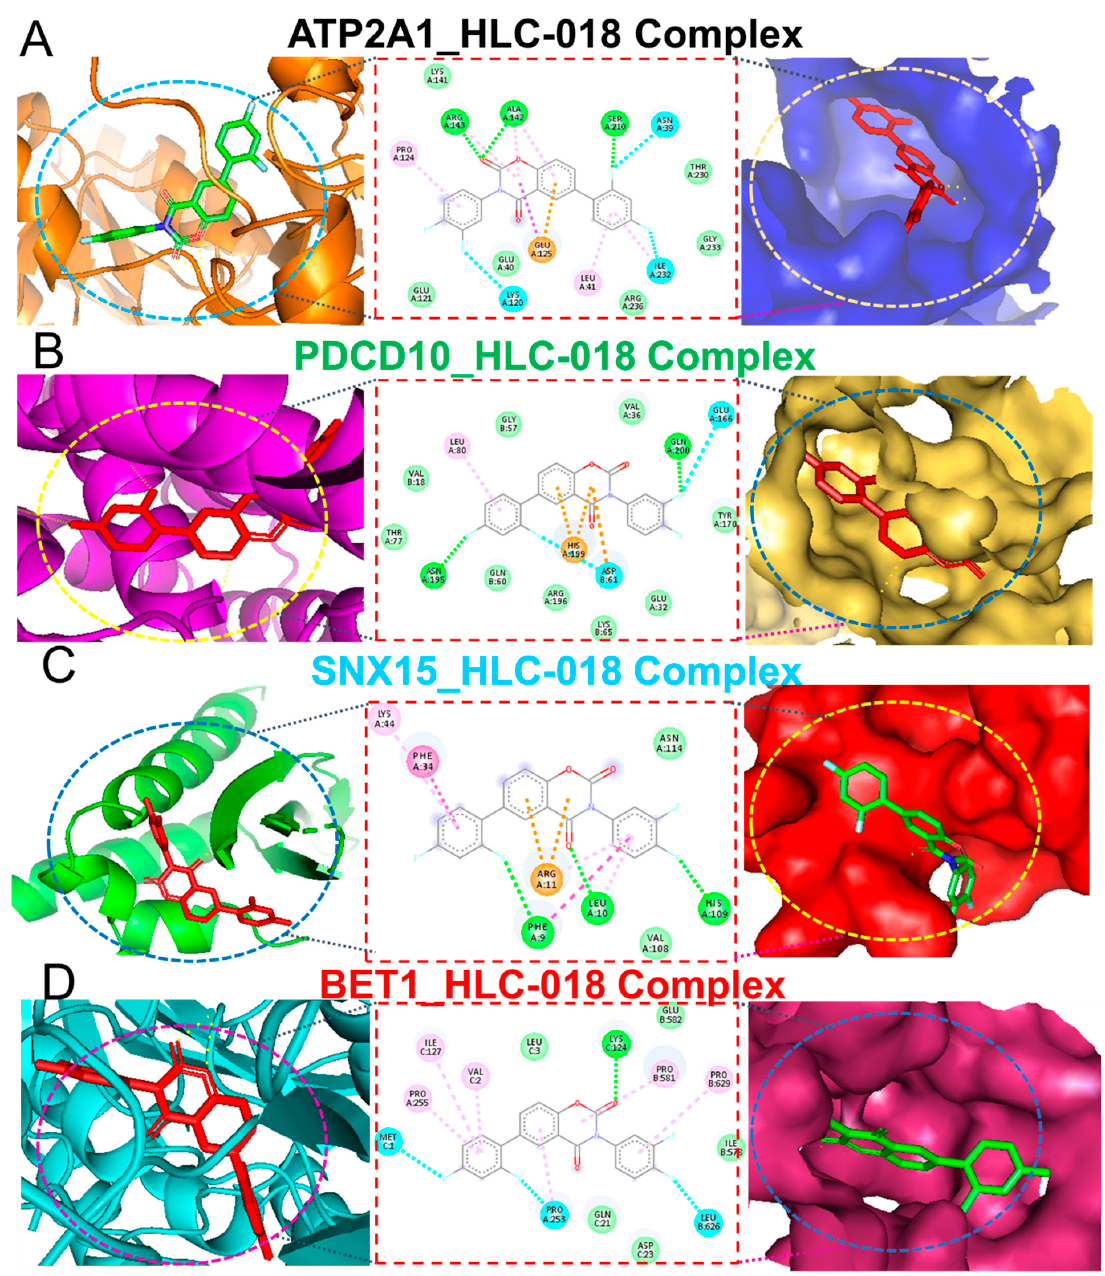
Figure 9. Ligand-receptor interaction profiles of HLC-018 in complex with ( A ) ATP2A1 , ( B ) PDCD10 , ( C ) SNX15 , and ( D ) BET1 . The left and middle panels respectively show two-(2D) and three-dimensional representations of ligand-receptor complexes, which reveal interacting amino acid residues and the type of interactions between the CHOL-hub genes and HLC-018. The right panels show the position of HLC-018 at the binding pocket flap of CHOL-hub genes.